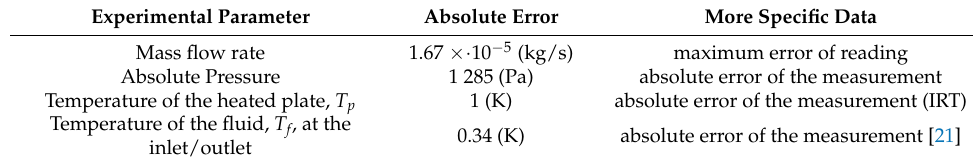
Table 3. Absolute errors of the main experimental parameters